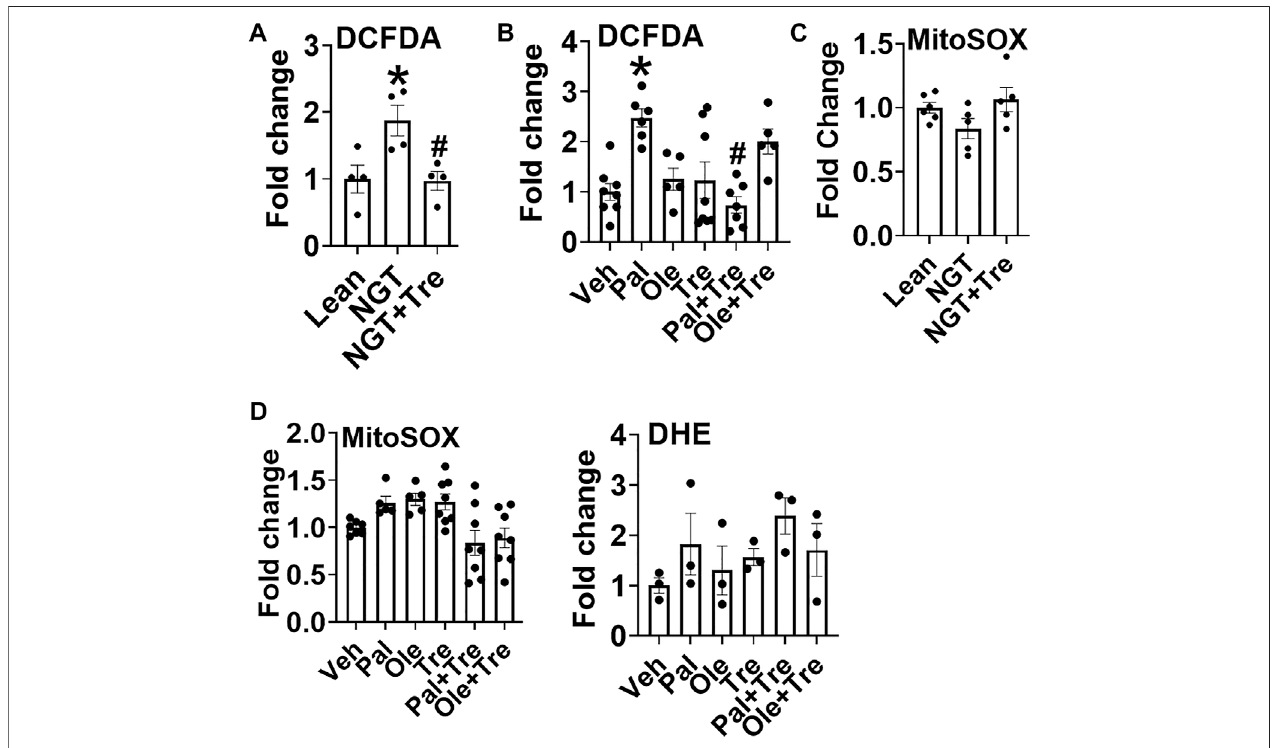
FIGURE 6 | Trehalose lowers cellular peroxide but not superoxide. (A) Peroxide production in cells from NGT subjects as measured by DCFDA fl uorescence. (B) Peroxide production in cells treated as indicated. (C) Mitochondrial superoxide production in cells from NGT subjects as measured by MitoSOX. (D) Mitochondrial (left panel) and cellular (DHE;right panel) superoxide production in cells treated as indicated . N = 3 – 8, A-D. Each N represents cells obtained from one subject. * p < 0.05 vs. Lean or Veh, # p < 0.05 vs. NGT or